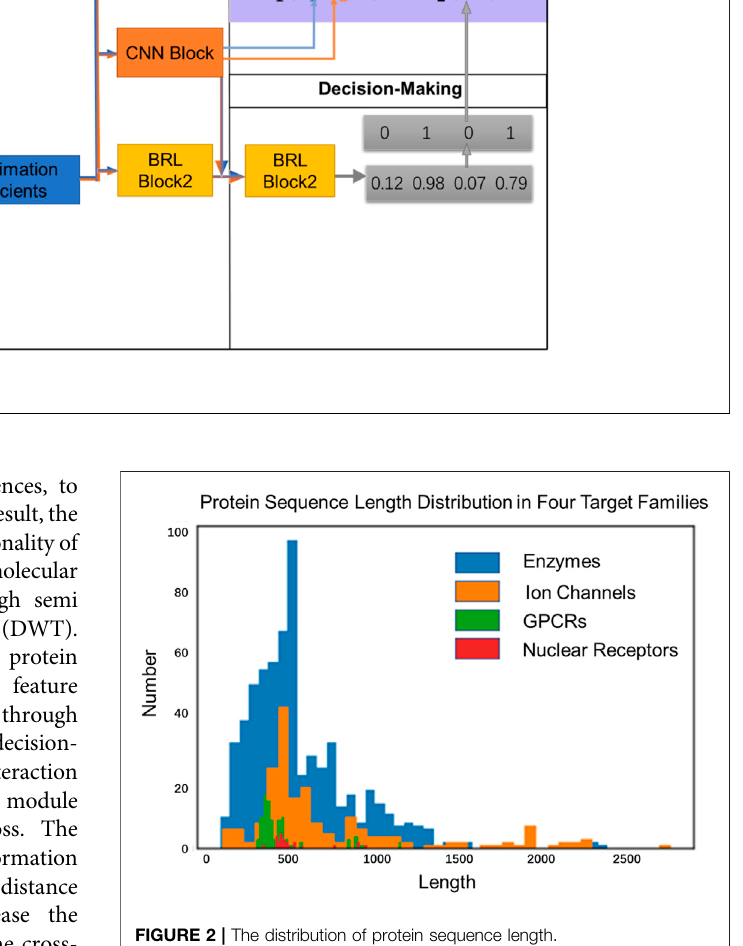
FIGURE 2 | The distribution of protein sequence